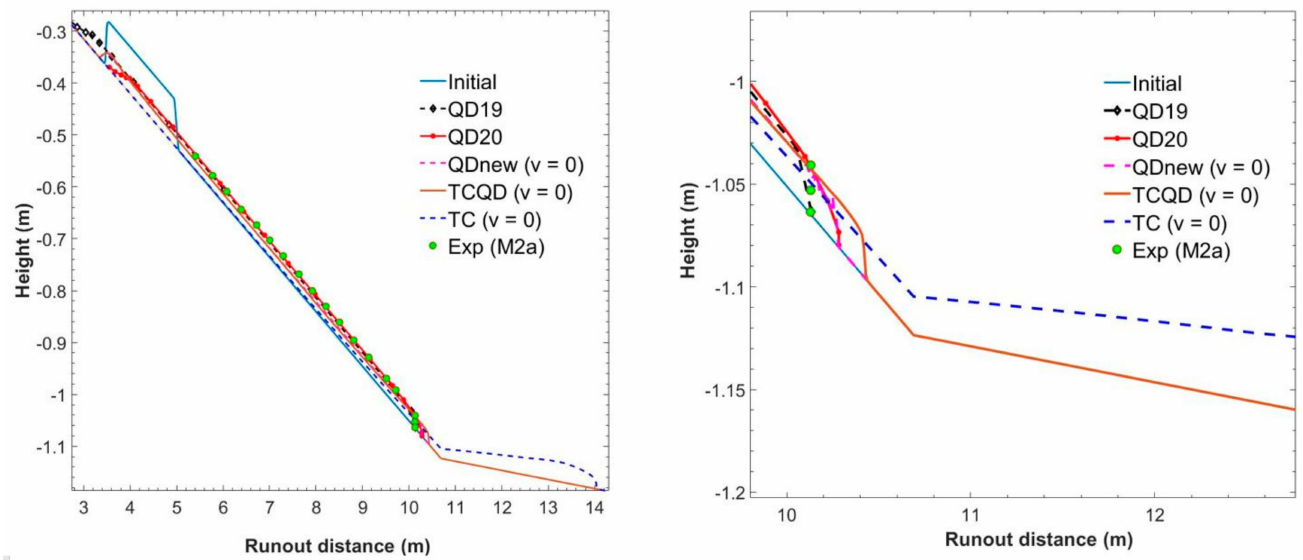
Figure 3. Comparison of debris-flow height between experimental and numerical data sets for case M2a (“Exp.” data from Mohrig et al. [23]; “Num. QD19, QD20” data from Qian and Das [7], Qian et al. [1],